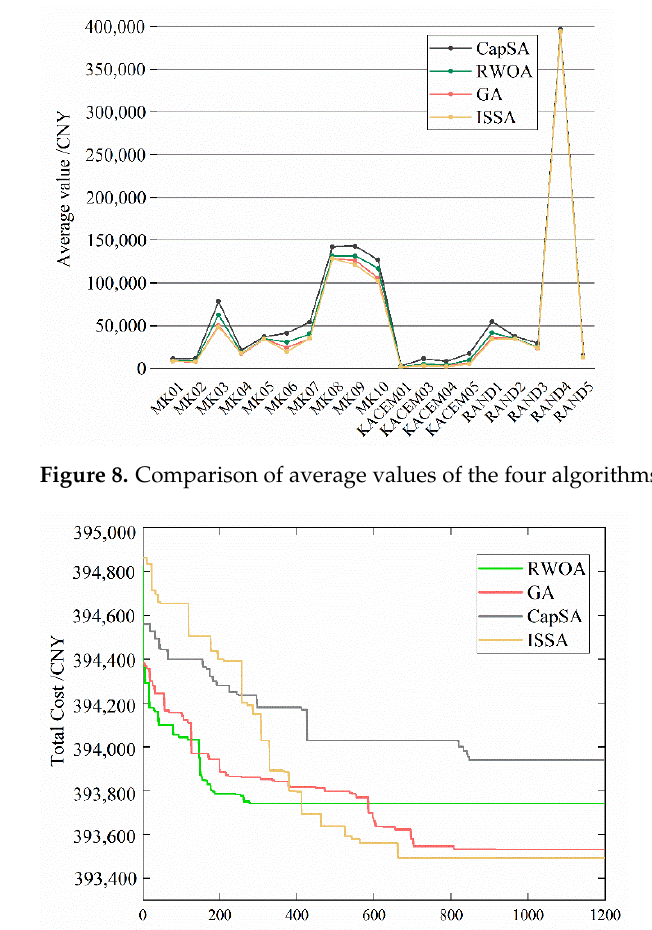
Figure 9. The convergence curve for the RAND4 instance obtained by the four algorithms.